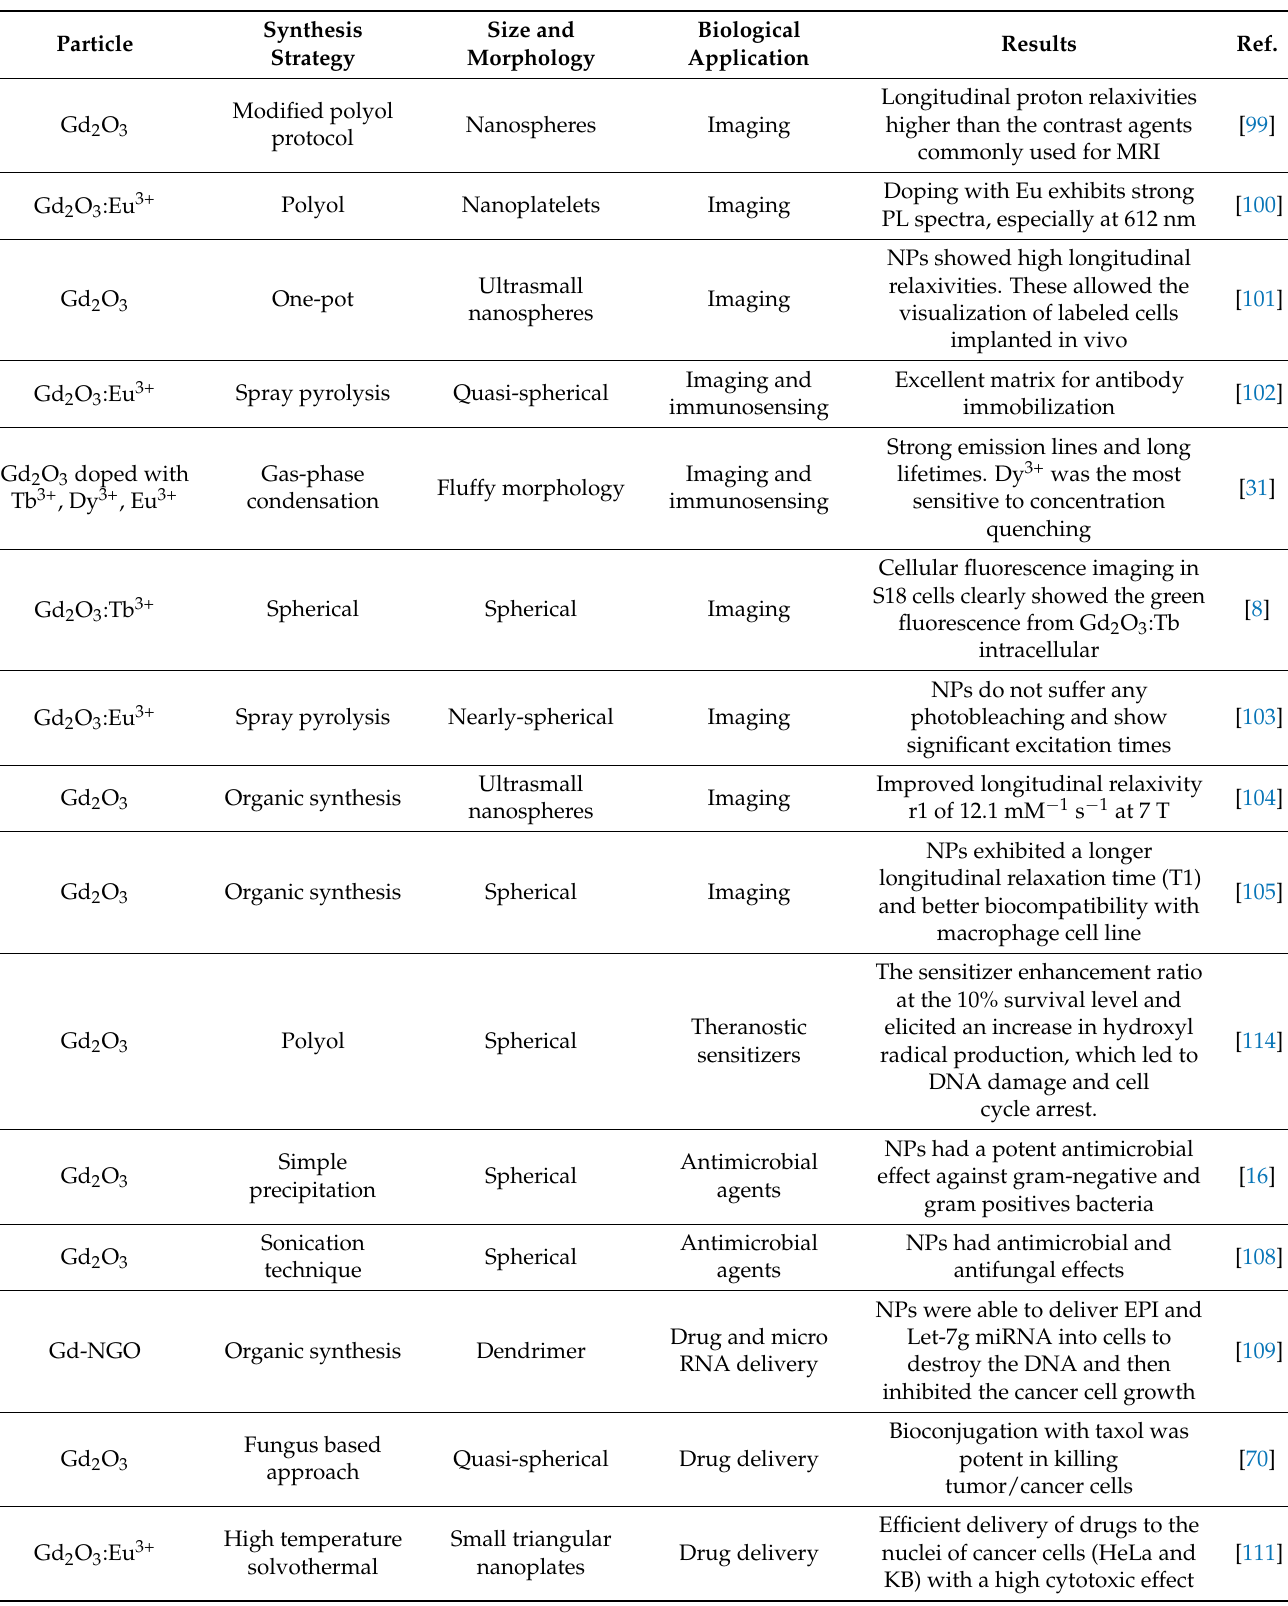
Table 1. A summary of the most used gadolinium-based nanoparticles in the biomedical